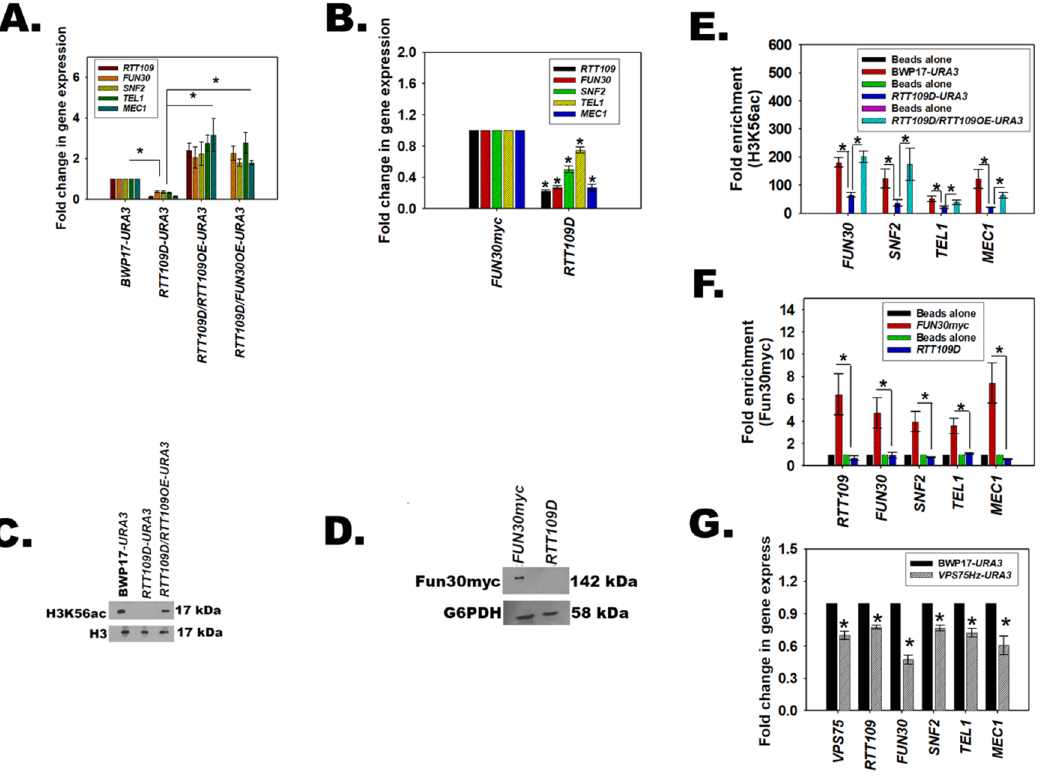
Figure 4. H3K56ac regulates the expression of FUN30 , SNF2 , TEL1 , and MEC1 . ( A ). Expression of RTT109 , FUN30 , SNF2 , TEL1 , and MEC1 was analyzed in BWP17- URA3 , RTT109D - URA3 , RTT109D/RTT109OE-URA3 , and RTT109D/FUN30OE-URA3 using qPCR. ( B ). Expression of RTT109 , FUN30 , SNF2 , TEL1 , and MEC1 was analyzed in FUN30myc and RTT109D strains using qPCR. This data is presented as average ± s.e.m. of three technical replicates. ( C ). Expression of H3K56ac was analyzed by western blot in BWP17 -URA3 , RTT109D - URA3 , RTT109D/RTT109OE-URA3 strains. H3 was used as the internal control. ( D ). Expression of Fun30myc was analyzed by western blot FUN30myc and RTT109D strains. G6PDH was used as the internal control. ( E ). Occupancy of H3K56ac on FUN30 , SNF2 , TEL1 , and MEC1 promoters was analyzed using ChIP in BWP17- URA 3, RTT109D - URA3 , RTT109D/RTT109OE-URA3 strains. ( F ). Occupancy of Fun30myc on RTT109 , FUN30 , SNF2 , TEL1 , and MEC1 promoters was analyzed using ChIP in FUN30myc and RTT109D strains. ( G ). Expression of VPS75 , RTT109 , FUN30 , SNF2 , TEL1 and MEC1 was analyzed in BWP17- URA3 and VPS75Hz-URA3 strains by qPCR. Unless stated otherwise, the qPCR and ChIP data are presented as average ± s.e.m. of three biological replicates. * p < 0.05. The western blots were repeated for three biological replicates and one representative image is shown.